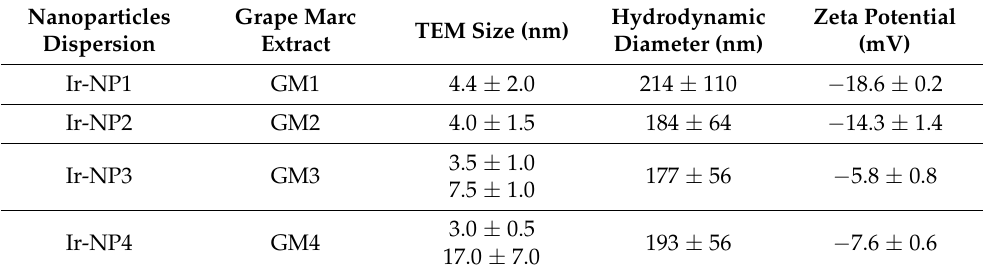
Table 2. TEM and DLS features of synthesized Ir-NPs.